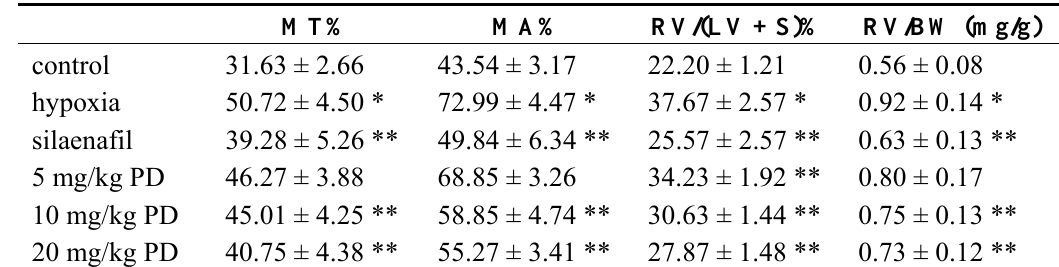
Table 2. Effects of polydatin on pulmonary artery remodeling and right ventricular hypertrophy in chronic hypoxic rats. n = 8. MT: medial wall thickness; MA: media cross-sectional area; RV: right ventricle; LV: left ventricle; S: septum; BW: body weight.